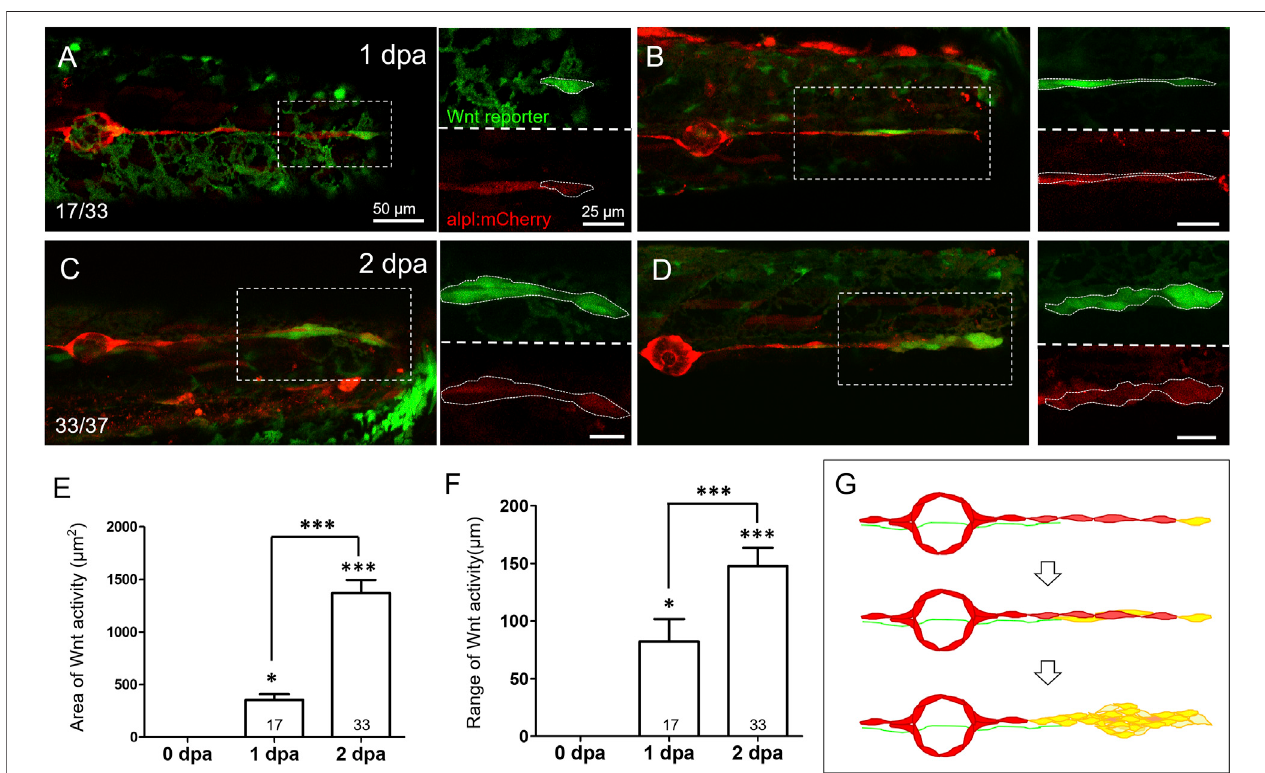
FIGURE 4 | Wnt activity is enhanced in the lateral line near the injured site at 1 – 2 days post-injury. Representative superimposed stacked images of two different larvae (A - C) and (B - D) from the cross of Tg(6XTcf/LefBS-miniP:d2GFP) (green) and Tg( − 4.7alpl:mCherry) (red) at 1-day post-amputation [dpa, (A - B) ] and 2 dpa (C - D) are shown. Magni fi ed diagrams for each dashed rectangle are shown next to the corresponding superimposed photo at the green or red channel. Elevated green Wnt activity outlined by white dashed lines was observed in the surrounding lateral line interneuromast cells near the wound site from 1 dpa. Scales are the same for all superimposed images (A) . Scale bars are 25 μ m in magni fi ed images. (E - F) The areas and range of Wnt activity, de fi ned by measuring the extension from tail-cut to the most proximal end, were calculated and shown. Data represent mean ± s.e.m. and are analyzed by one-way ANOVA compared to 0 dpa. In addition, the difference between 1 and 2 dpa was analyzed and shown. * p < 0.05, *** p < 0.0005. (G) A series of cartoons illustrates Wnt activity elevation (yellow) during cluster